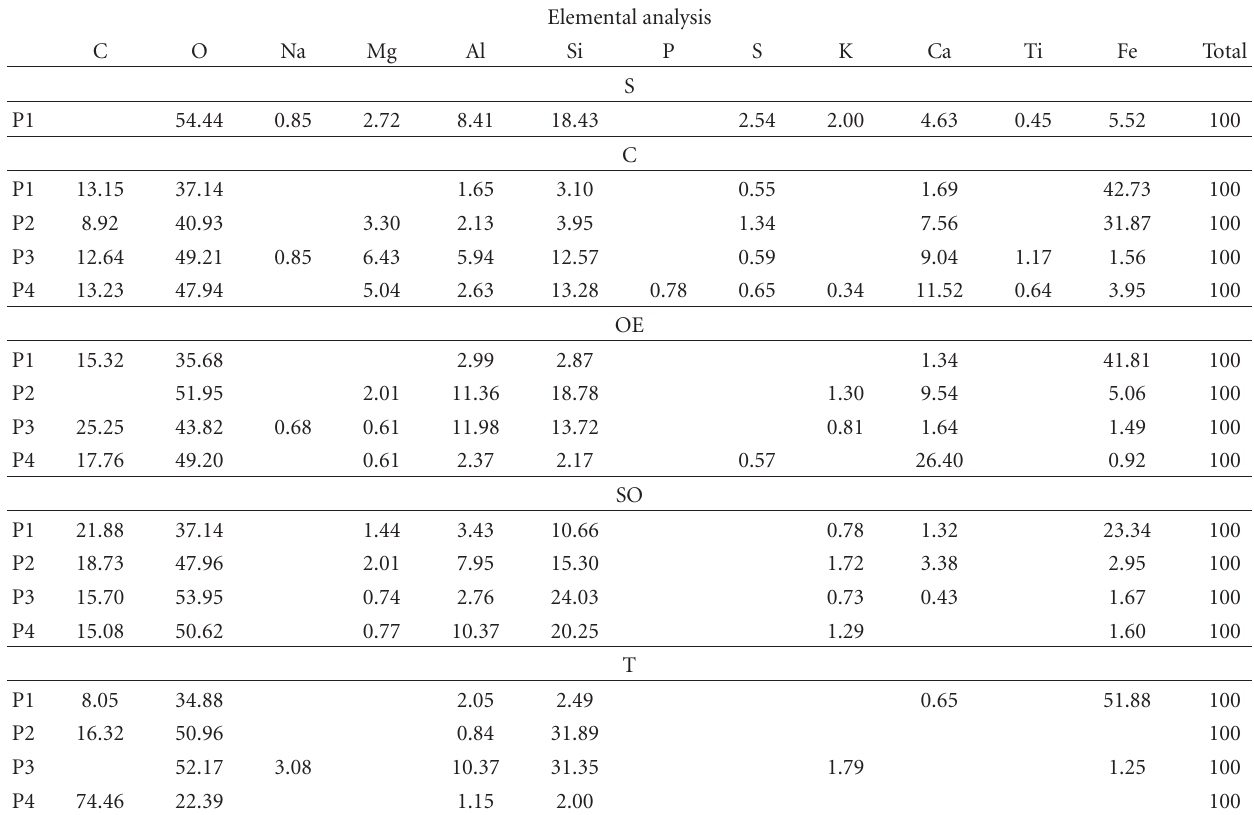
Table 5: SEM-EDS elemental analyses of